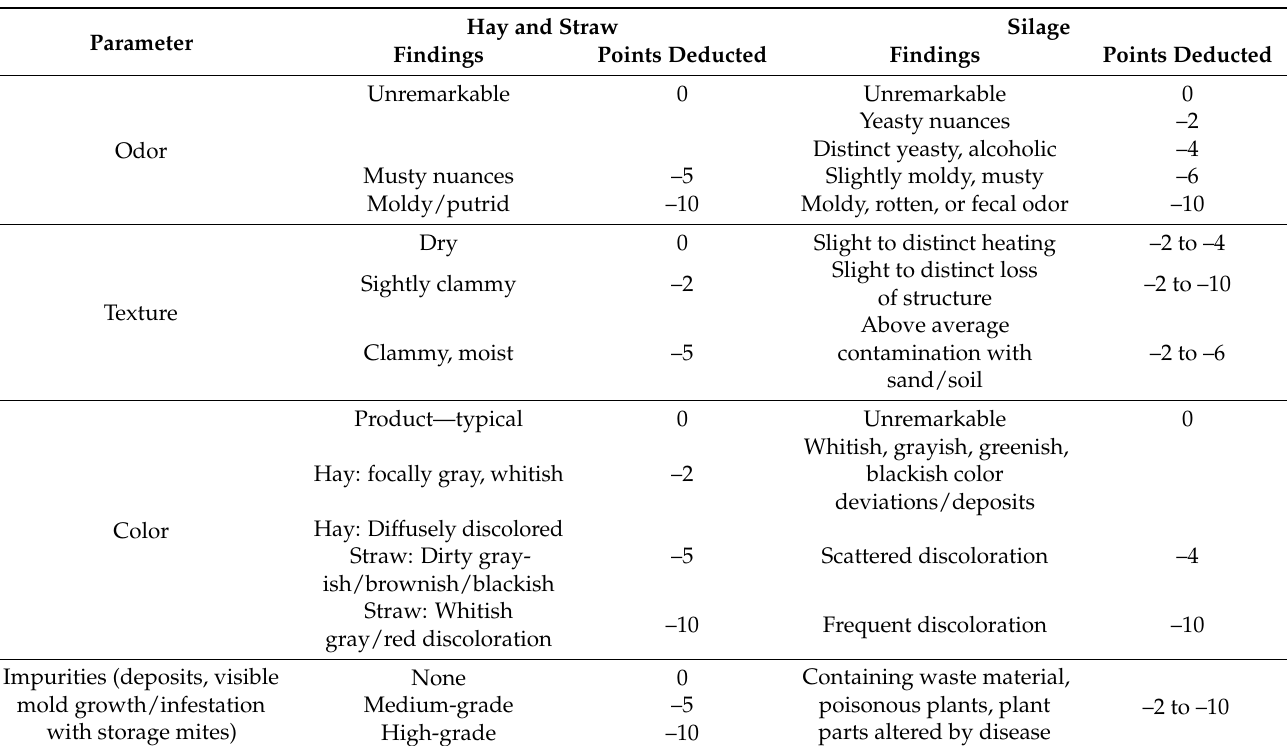
Table 1. Evaluation of the hygienic status of hay, straw, and silage by sensory analysis in accordance with Kamphues et al.